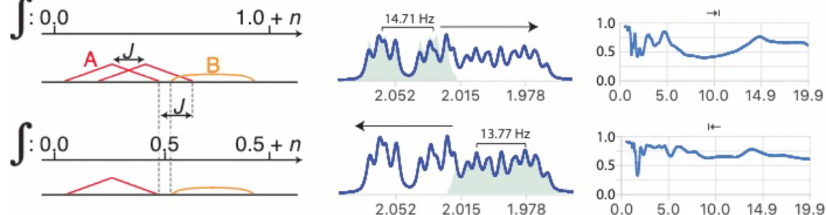
Figure 8. Analysis of multiplet A in the presence of partially overlapping multiplet B with relative integrals of 1 and n , respectively. When deconvolution is successful, the left-to-right deconvolution process eliminates the second occurrence of sub-multiplet A which effectively eliminates overlap (bottom left). (Right) Example of separation of two slightly overlapping multiplet structures from a sample of artemicinin dissolved in CDCl 3 . The coupling constants J = 14.71, 4.77, 2.89 and 13.77, 6.15, 3.91 and 2.93Hz were extracted from the left and right multiplets, respectively, and used to reconstruct the matching green multiplets. Note the slight mismatch due to second-order effects which could be ignored in this analysis. See Fig. S7 in the Supplement for the detailed